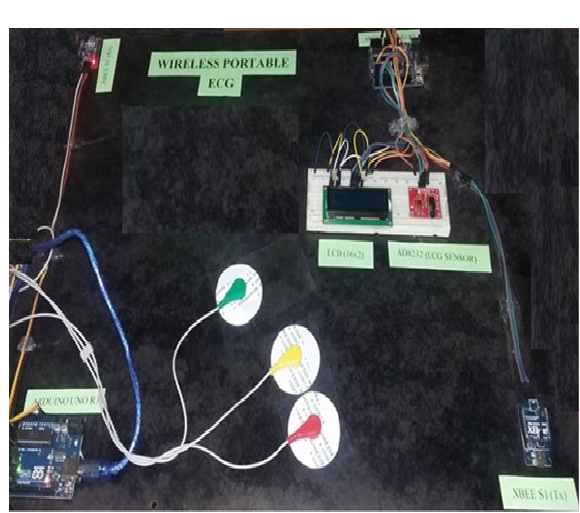
Figure 4. Design layout